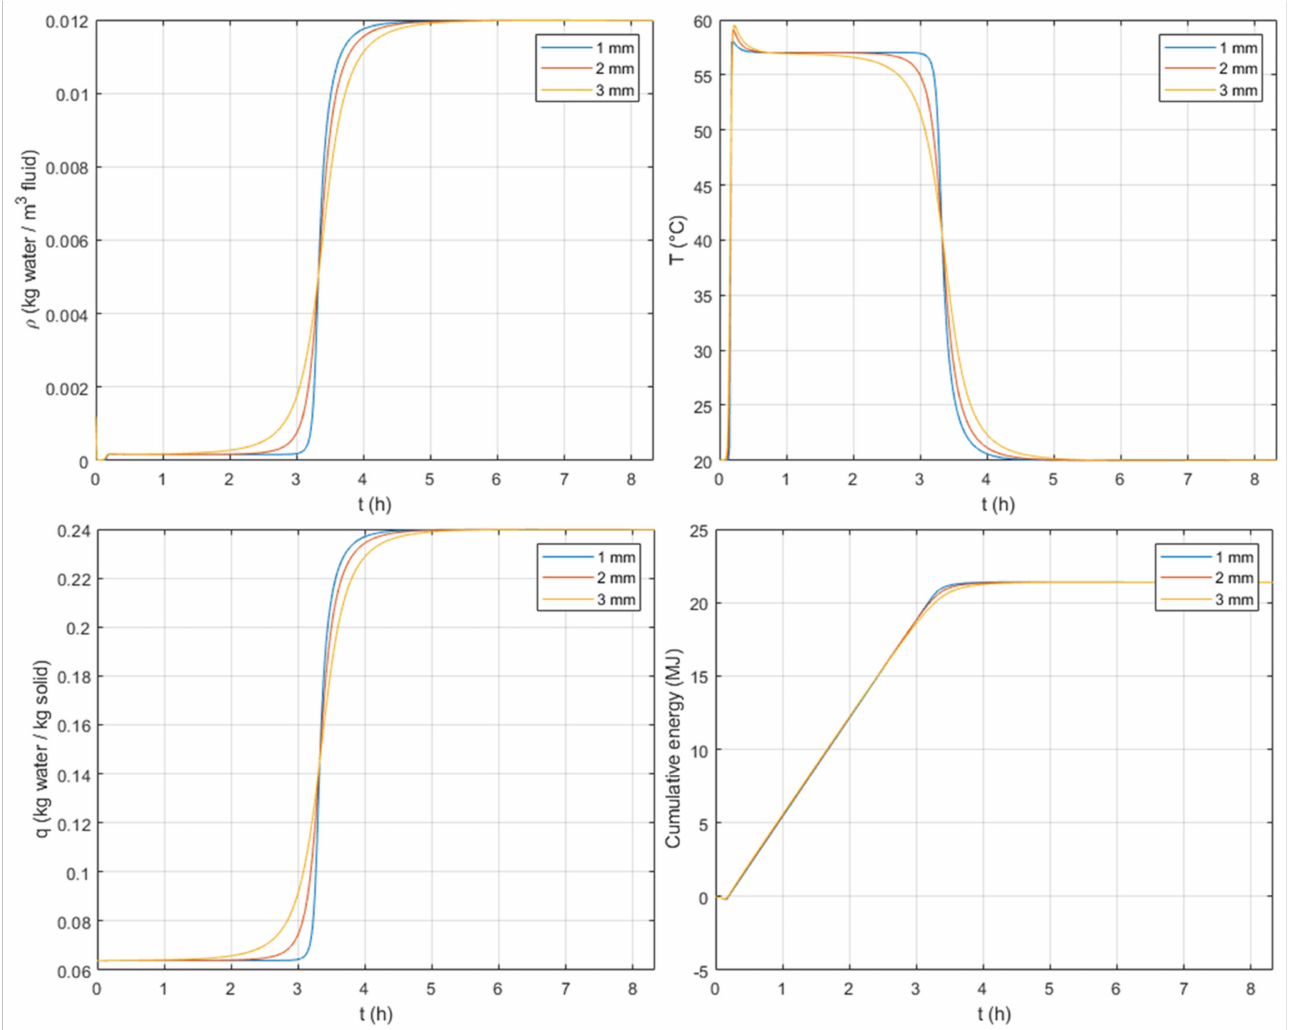
Figure 12. Parametric analysis of the adsorbent particle size and study of the evolution with time of water fluid concentration, fluid temperature, water adsorbed concentration, and cumulated heat at the column